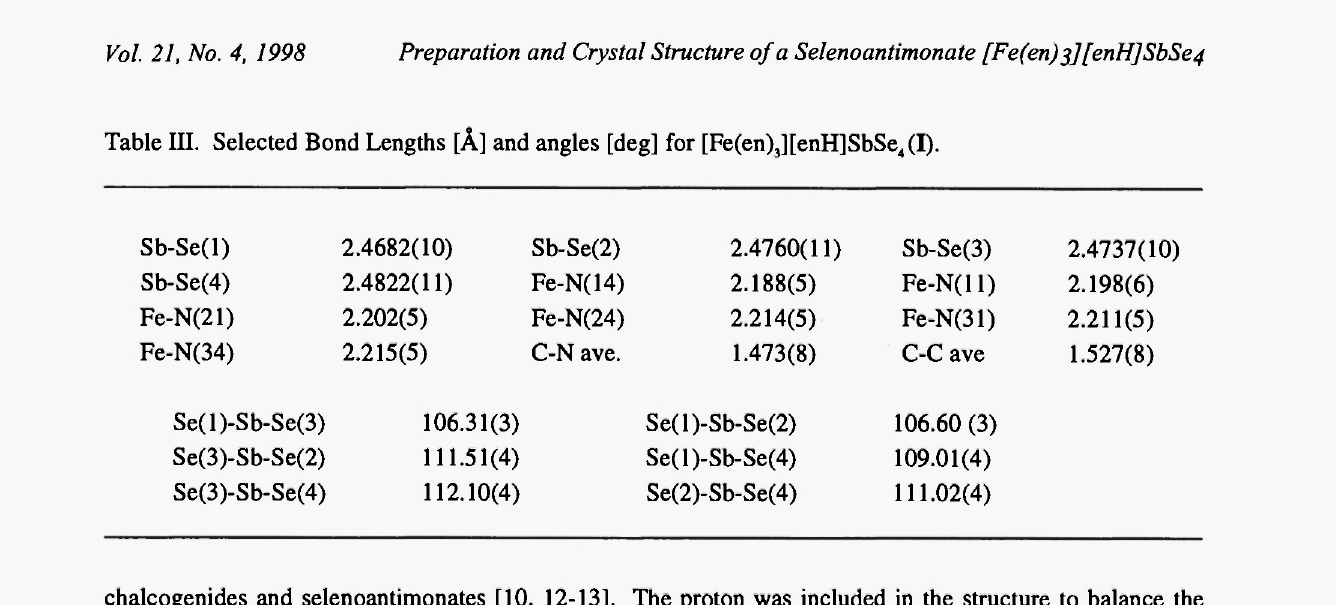
Table III. Selected Bond Lengths [Ä] and angles [deg] for [Fe(en)